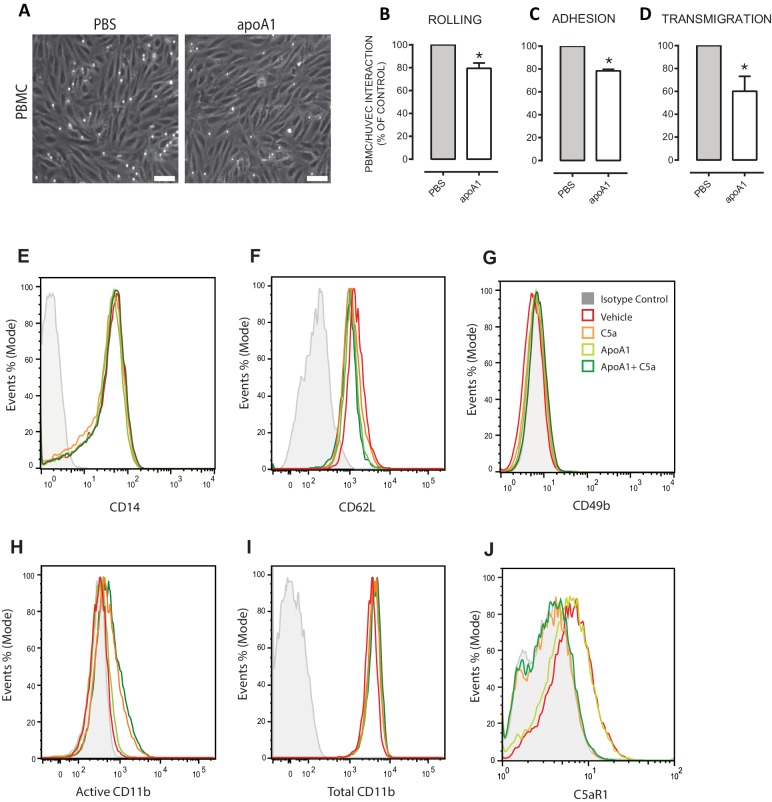
Acute pre-treatment with apoA1 reduces PBMC:HUVEC interactions under flow.Isolated PBMCs (1 × 106 cells/ml) were incubated with apoA1 (40 µg/ml) or buffer (control) for 60 min prior to perfusion over TNF-α stimulated HUVECs. Panel (A) are representative images of PBMC:HUVEC interactions following treatment with apoA1 vs control (Scale bar 20 µm). PBMC (B) rolling, (C) adhesion and (D) transmigration were quantified from six random fields/treatment. Results are expressed as percentage of control of two independent experiments. Statistical analysis was conducted with Mann-Whitney U test. 650 *p,0.05, versus control; n = 4 donors. (A) Human CD14+ monocytes were isolated (1 × 106) and pre-treated with apoA1 (40 μg/ml) for 60 min before being stimulated with 10 nM C5a for 5 min. Representative histograms from flow cytometry for (E) CD14, (F) CD62L, (G) CD49b, (H) active CD11b, (I) total CD11b and (J) C5aR1 expression levels are shown from a total of four independent donors.